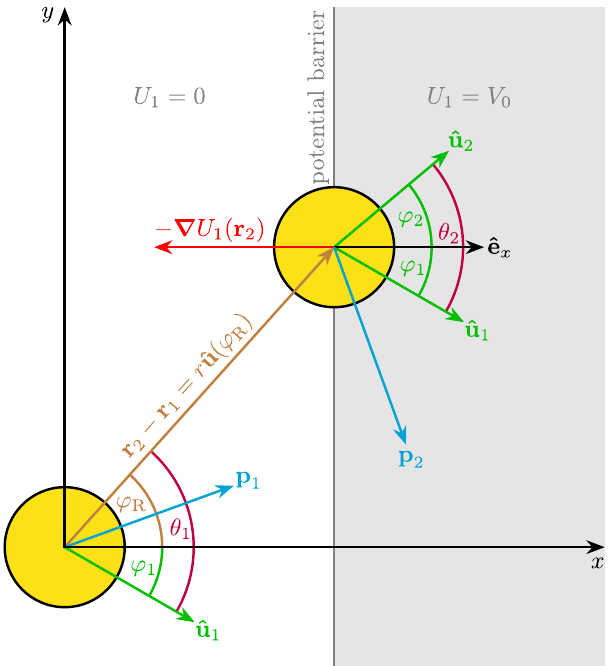
Fig. 4 | Visualization of the microscopic setup considered in the derivation. Here, x and y are the components of r and ^ e x is the unit vector in x direction. Each particle ’ s state is characterized by the degrees of freedom r i (position), p i (momentum), and ^ u i (orientation).Byexploiting the symmetries of the system, we can pass to a reduced description in terms of the vector r ^ u ð φ R Þ pointing from particle1toparticle2andtheangles θ 1 and θ 2 de fi nedrelativetotheorientationof particle 1. A force arises at the boundary of the potential barrier inside of which U 1 = V 0 . The setup isa generalization of the overdamped one shown in Fig. 1 of the article by Jeggle et al. 93